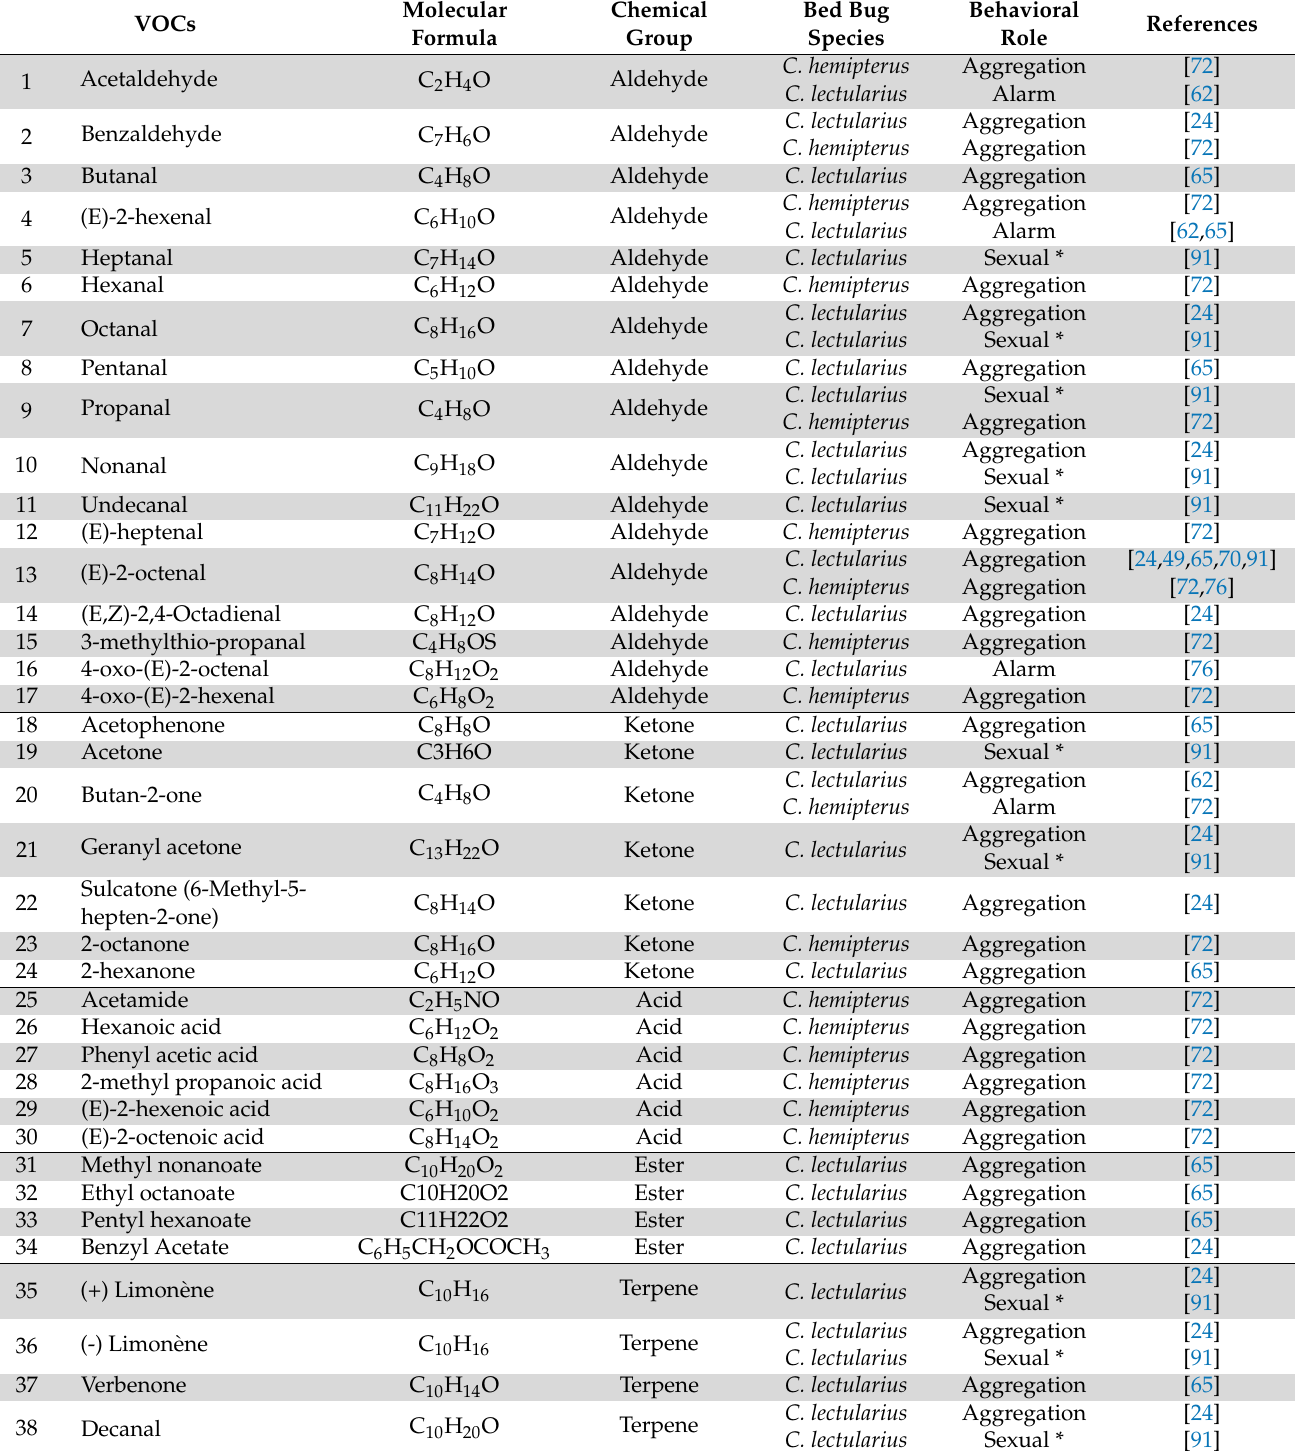
Table 1. Volatile organic compounds detected in the bed bugs and their known